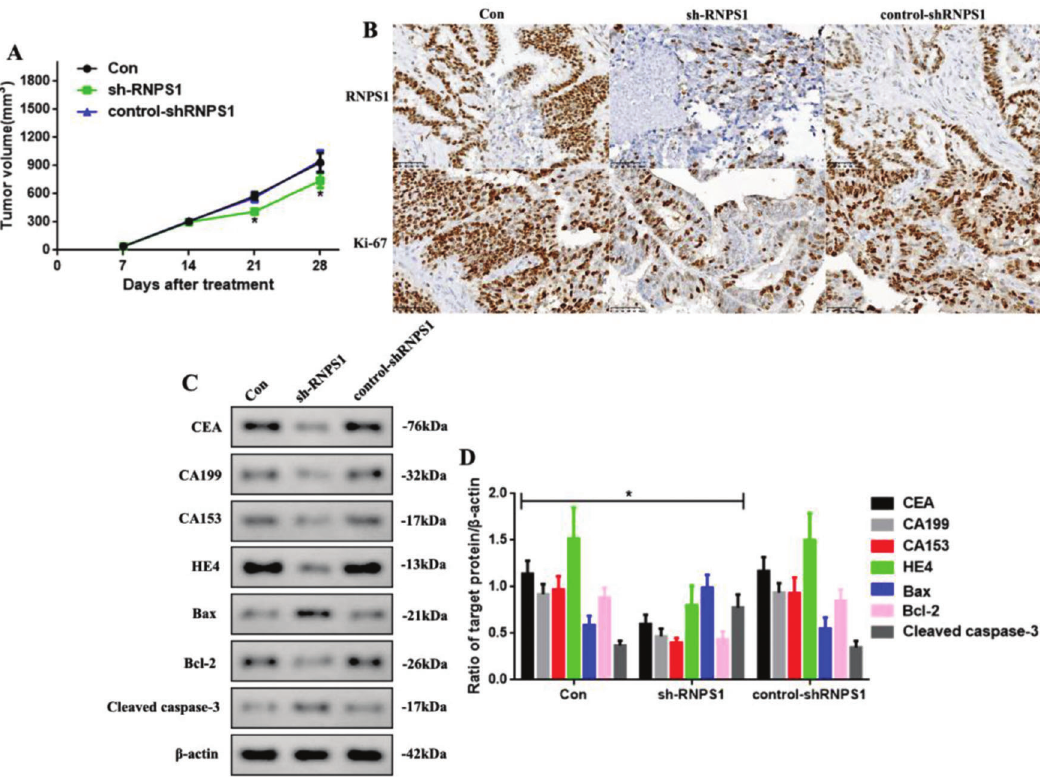
Figure 4 - (A) Tumor volume in mice from the Con, sh-RNPS1, and control-shRNPS1 groups at 28 days. (B) IHC analysis for detecting the RNPS1 levels and Ki-67 index. (C) Western blots for the analysis of the levels of CEA, CA199, CA153, HE4, Bcl-2, Bax, and cleaved caspase-3, (D) Quantitation of the levels of CEA, CA199, CA153, HE4, Bax, Bcl-2, and cleaved caspase-3. (n=6, * p o 0.05: sh-RNPS1 vs. other groups).